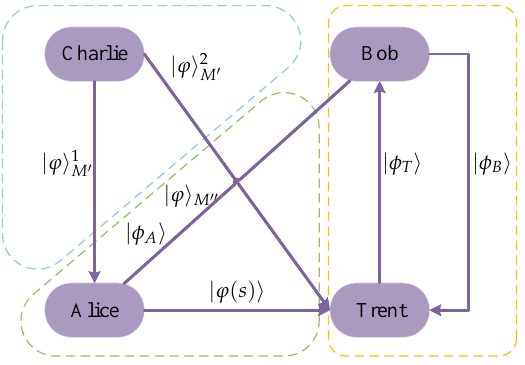
Figure 8. Schematic of the designed quantum proxy signature scheme Figure 2. Schematic of the designed quantum proxy signature scheme. Charlie, Alice, Bob, and Trent are the original signer, the proxy signer, the verifier and the arbitrator, respectively. Notably, blue dashed box represents the initializing phase and authorizing phase, and green represents the signing phase and orange represents the verifying